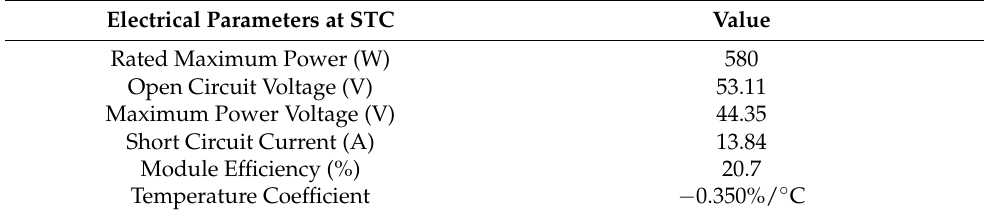
Table 3. Some of the main electrical parameters of the JAM78S30 580/MR PV module from JA Solar, with a surface area of 2.64 m 2 , at an STC corresponding to an irradiance of 1000 W/m 2 , cell temperature of 25 ◦ C, and AM 1.5 G.